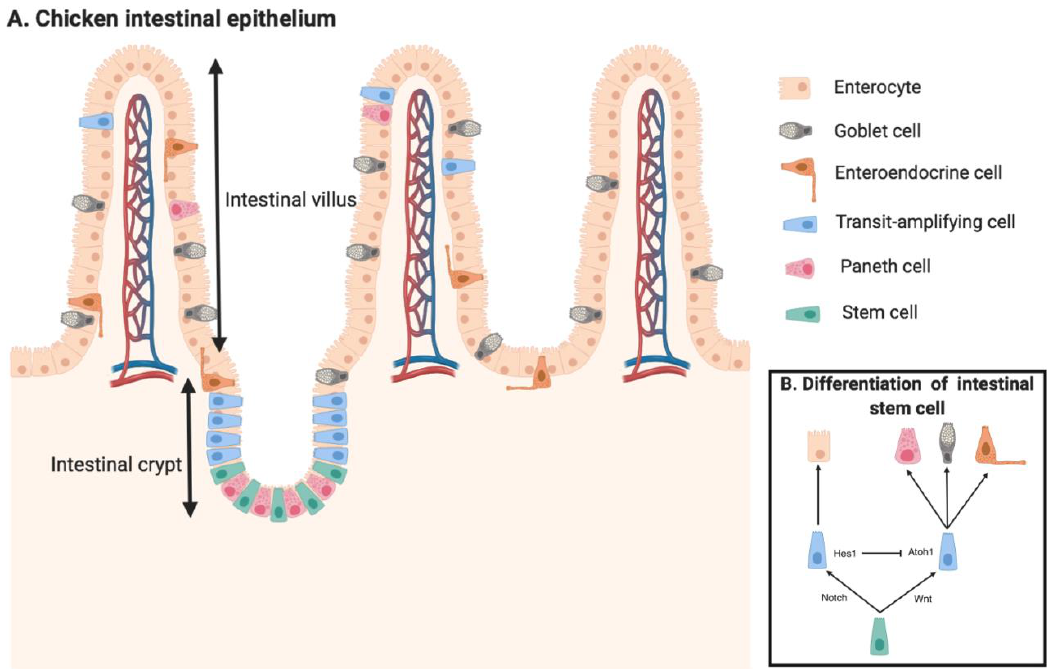
Figure 1. Chicken small intestinal epithelium model. The chicken intestinal epithelium is a complex biosystem that has multiple functions. ( A ) The intestinal crypt invaginates as a pocket and the intestinal villus protrudes as a finger structure. Intestinal stem cells are located at the crypts and di ff erentiate into transit-amplifying cells for further di ff erentiation into mature epithelial cell populations (enterocytes, goblet cells, enteroendocrine cells, and Paneth cells). ( B ) The model for the di ff erentiation of the intestinal stem cell is a process of the intermediate di ff erentiation from stem cells to transit-amplifying (TA) cells, and the terminal di ff erentiation from TA cells to absorptive enterocytes, secretory goblet, Paneth, and enteroendocrine cells, which is mediated by the synergistical regulation of Notch and Wnt signals.